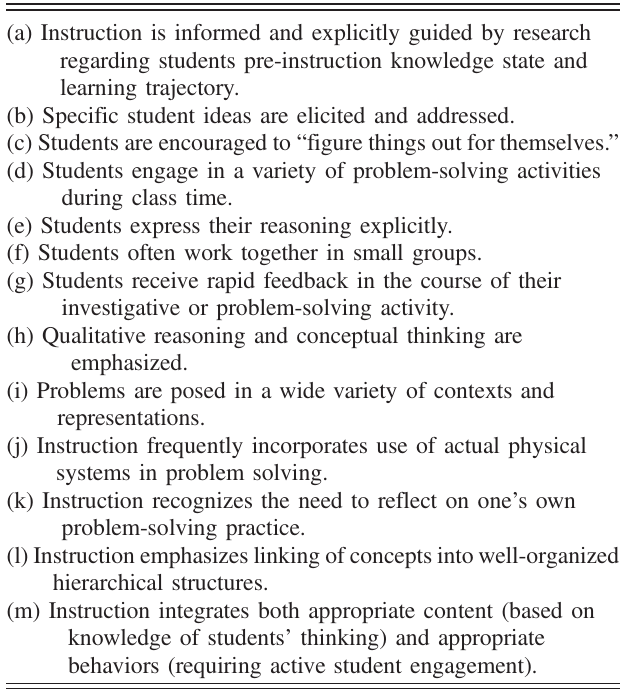
TABLE II. Meltzer and Thornton ’ s characteristics shared by most research-based active-learning instructional methods in